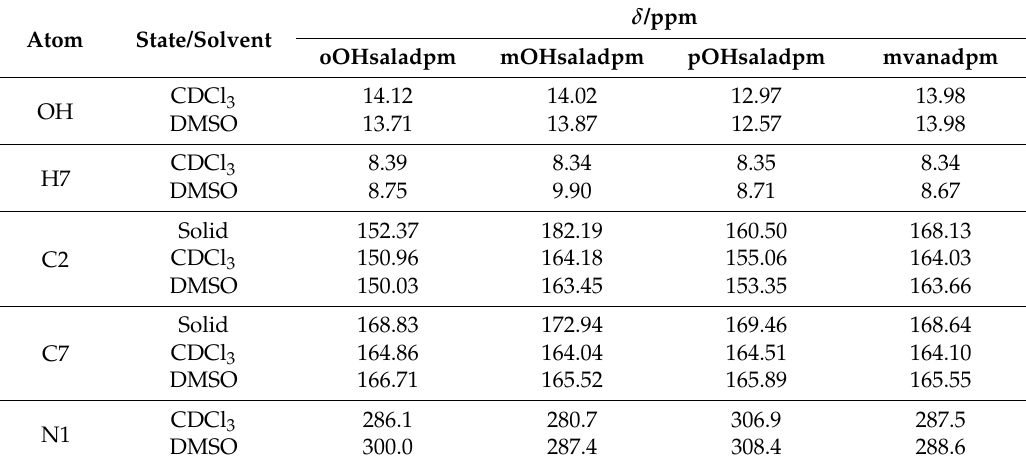
Table 1. Selected NMR chemical shifts (ppm) for investigated compounds in solid state and in CDCl 3 and DMSO-d 6 solutions, at 298 K. 15 N chemical shifts are reported relative to liquid